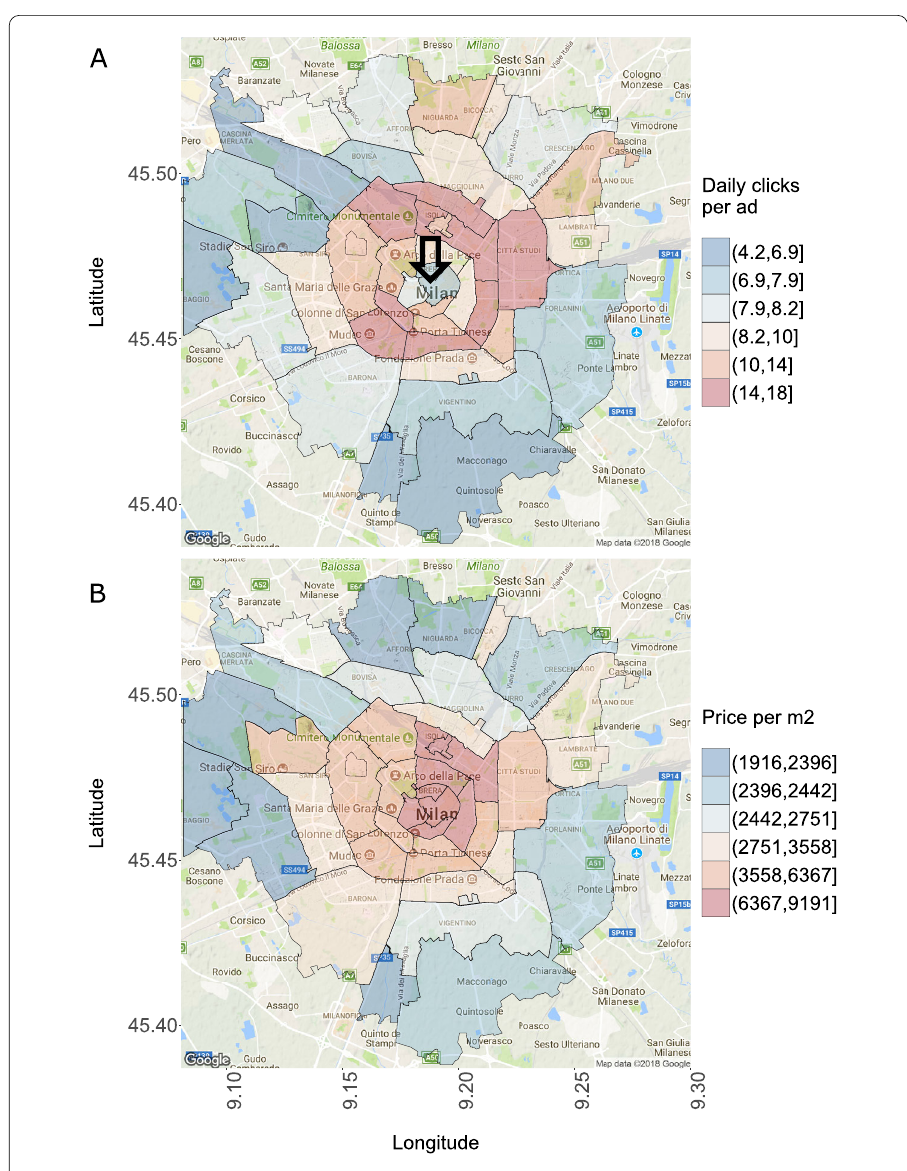
Figure 6 Clicks and price in Milan. Each polygon corresponds to an OMI microzone. ( A ) Daily clicks per ad, grouped in sixtiles. The arrow indicates the most central (and expensive) neighborhoods, in the lowest sixtiles of the clicks distribution. ( B ) Price per m2, grouped in sixtiles. Prices are highest in the center and decrease radially towards the peripheries